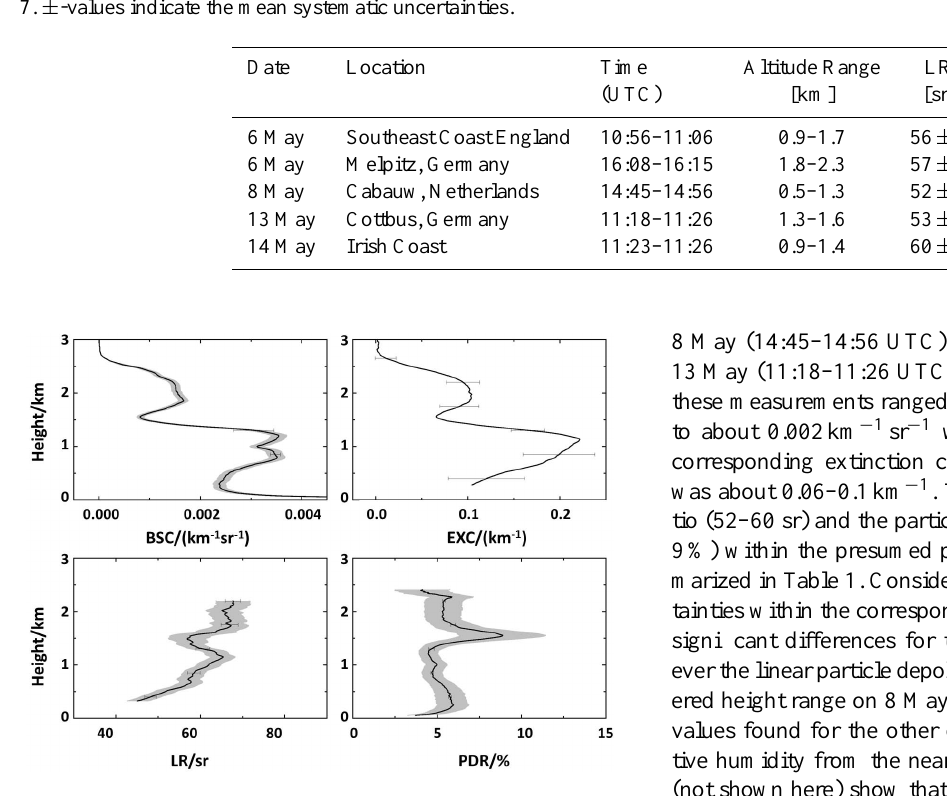
Fig. 6. HSRL vertical profiles of backscatter coefficient (BSC) (up- per left panel), extinction coefficient (EXC) (upper right panel), li- dar ratio (LR) (lower left panel) and particle linear depolarisation ra- tio (PDR) (lower right panel) at 532nm for the selected flight track south-west of Ireland on 14 May. The grey shaded areas mark the systematic error, the error bars the statistical